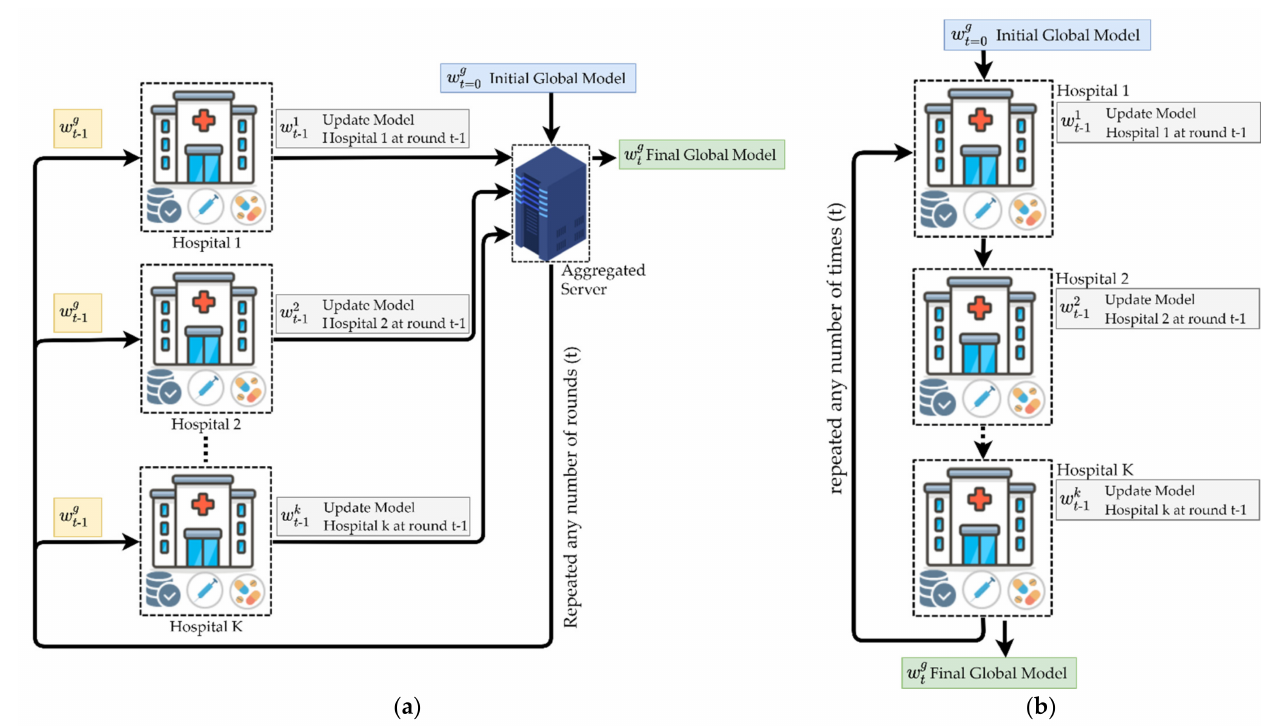
Figure 5. Federated learning framework for healthcare application based on aggregation schema. ( a ) Centralized FL: the central server selects the nodes, aggregates the updates, and sends back the updated global model parameters; ( b ) decentralized FL: to develop a global model, there is no central server to orchestrate all